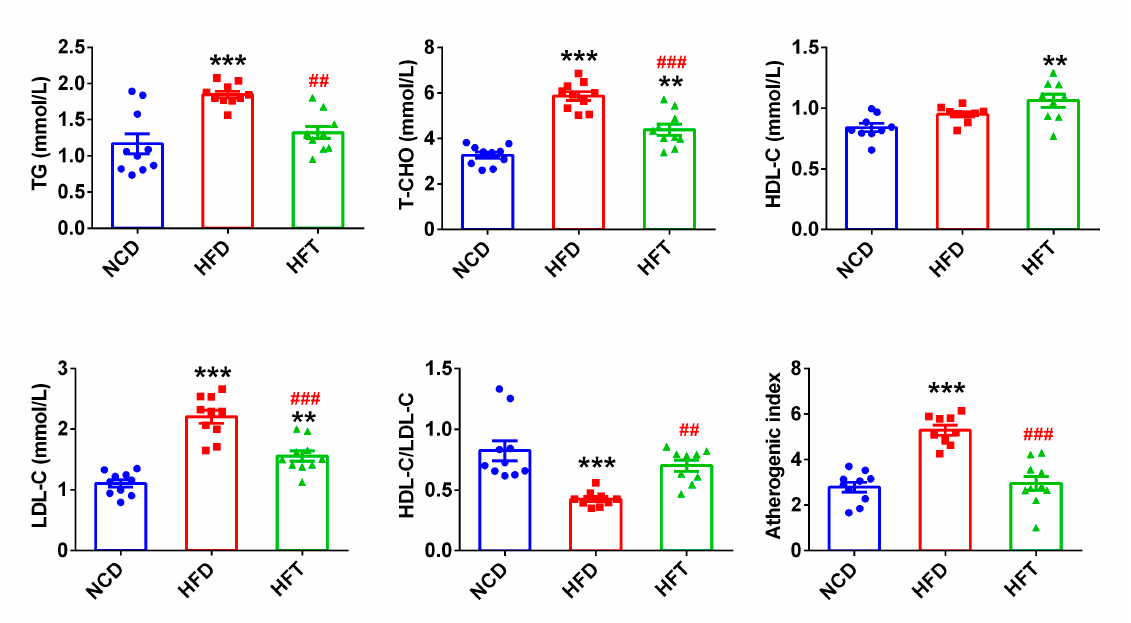
Figure 2. The e ff ects of T17 on serum lipids profiles in mice fed HFD for 10 weeks. Data are expressed Figure 2. The effects of T17 on serum lipids profiles in mice fed HFD for 10 weeks. Data are as mean ± SEM. Values marked with * are significantly di ff erent compared with NCD group and expressed as mean ± SEM. Values marked with * are significantly different compared with NCD values marked with # are significantly di ff erent compared with HFD group (** or ## p < 0.01, *** or group and values marked with # are significantly different compared with HFD group (** or ## p < ### p < 0.01, *** or ### p < 0.001).